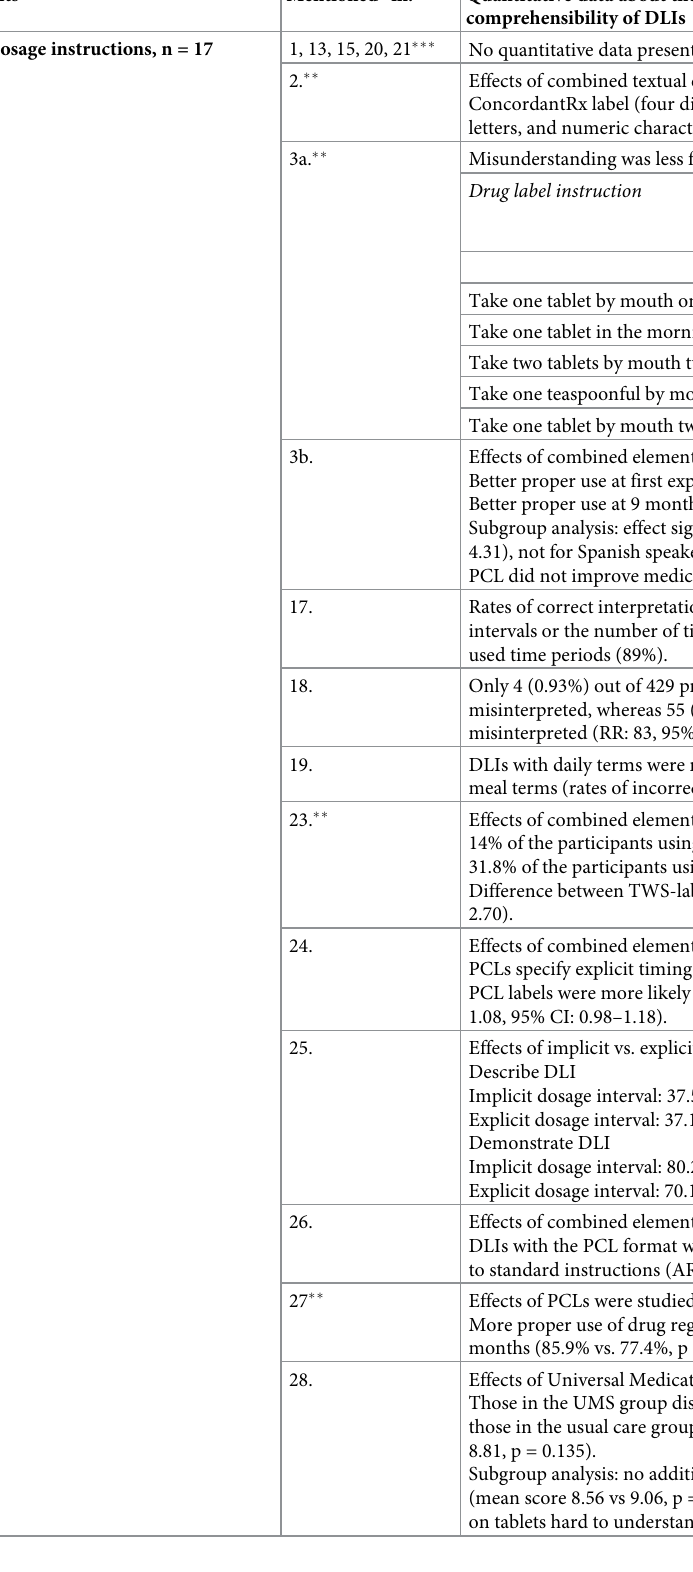
Table 4. The frequency of textual elements in the included studies, and, (if provided), an overview of the quantitative data on the effect of (combined) textual ele- ments on the comprehensibility of the DLIs (n = 28). Textual